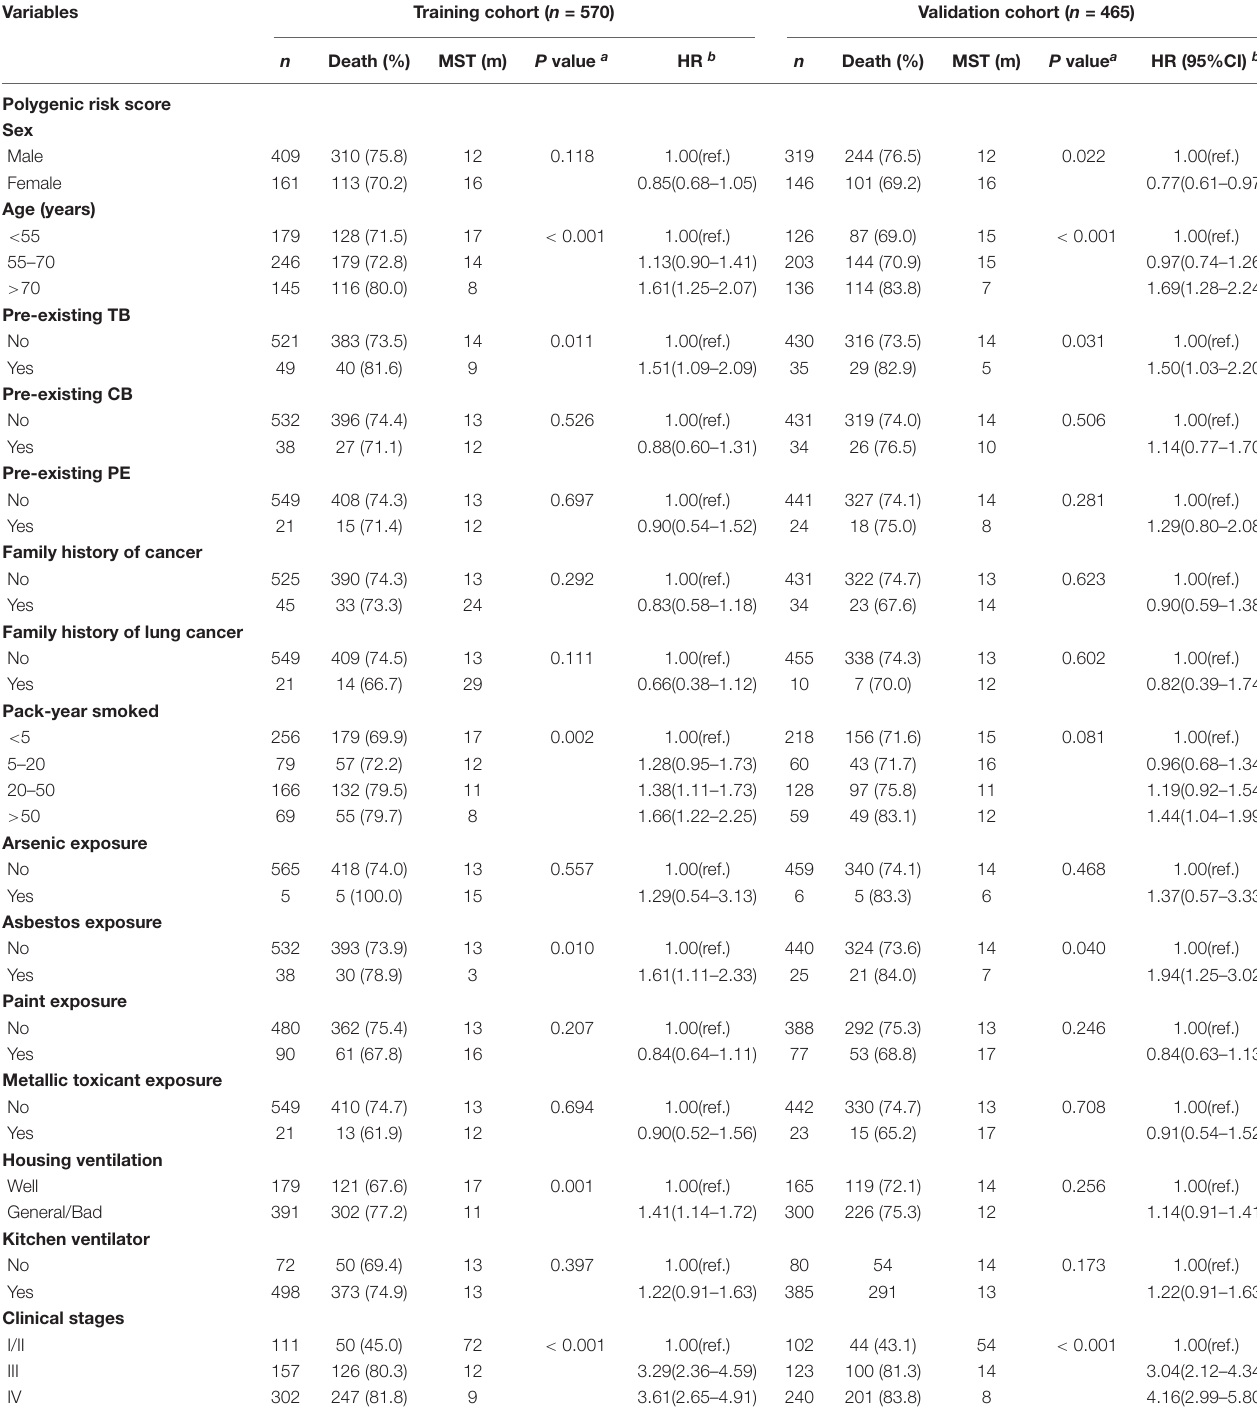
TABLE 1 | Analysis of the effects of NSCLC-affected individuals’ characteristics and clinical features on NSCLC